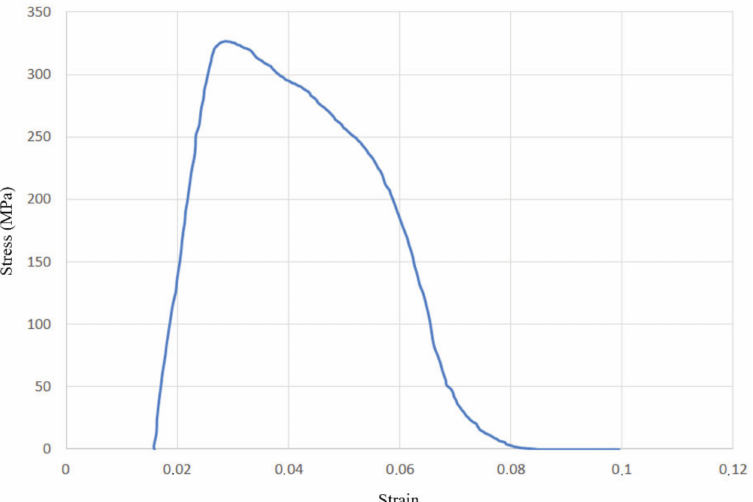
Figure 15. Stress–strain diagram for the group with misalignment, undercut, and excess root penetra- tion (group I).